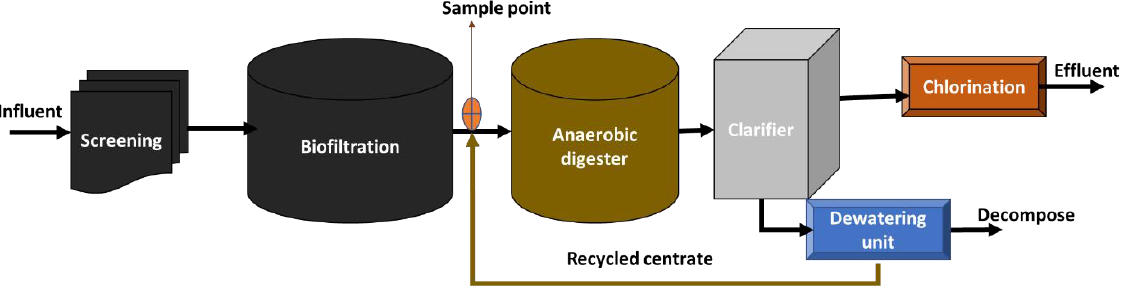
Figure 1. Block diagram of a local South African sugar refinery wastewater treatment plant.